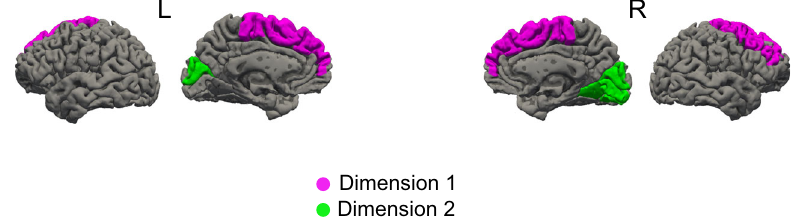
Fig. 4 Graphical representation of the regions contribution to each of the Dimensions resulting from the principal component analysis. Regions contributing to dimension 1 and 2, cortical thickness. Dimension 1 (pink): superior frontal gyri, the right middle frontal gyrus. Dimension 2 (green): bilateral cuneus and right occipital